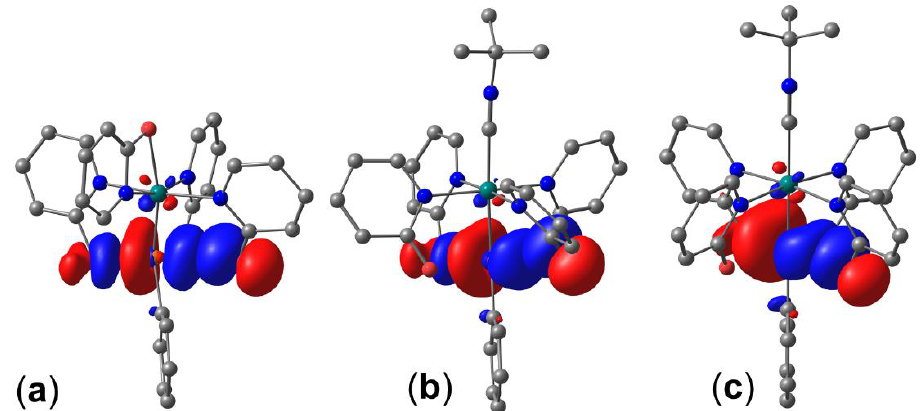
Figure 10. Visualization of NBOs (isosurface 0.05 au) involved in σ -O → P donor–acceptor interactions in ( a ) compound 3a , ( b ) compound 5a (for one of the two O → P interactions) and ( c ) compound 5b (for one of the two O → P interactions). Hydrogen atoms are omitted for clarity (for further O → P interactions in 5a and 5b , see Figure S33 in the Supplementary Materials).